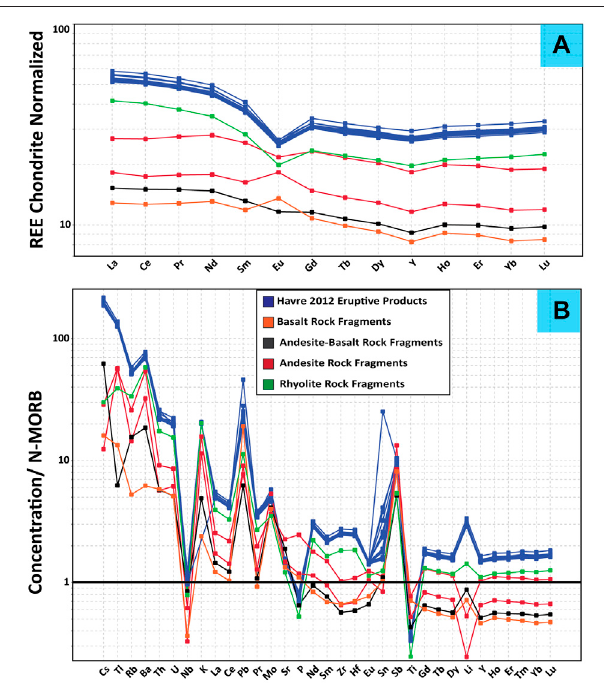
FIGURE 5 | Trace element spider diagrams of Havre 2012 pumice raft and embedded rock fragments. (A) Rare earth element spider diagram normalized to chondrite (McDonough at al., 1985). (B) Multi-element spider diagram normalized to N-MORB (Sun & McDonough, 1989).